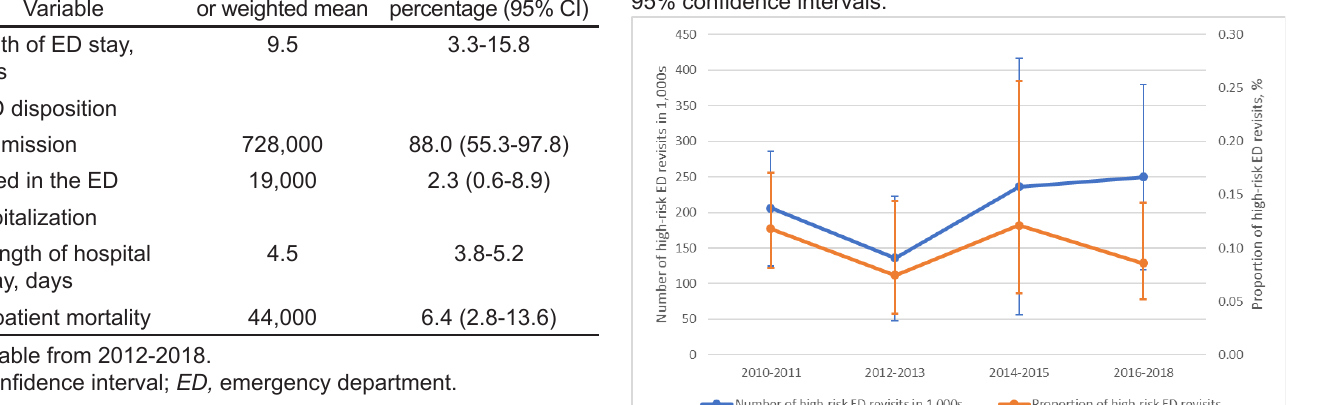
Table 3. Emergency department visit rates for high-risk revisit, overall, stratified, and multivariable analysis, 2010-2018.